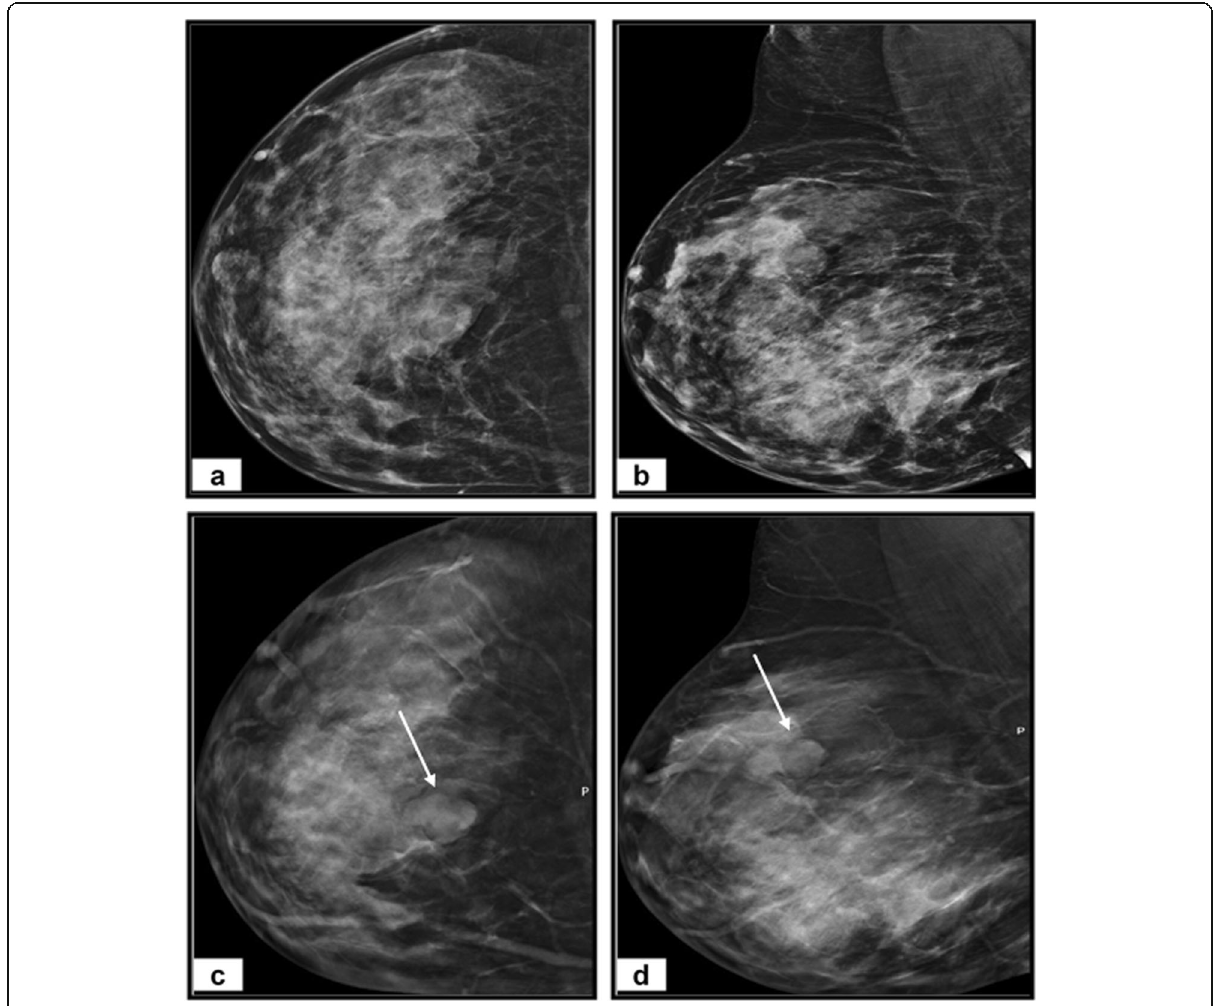
Fig. 5 A 36-year-old woman complains of a right breast lump. a Craniocaudal and ( b ) mediolateral oblique DM images of left breast reveal heterogeneous dense breast (BI-RADS C). The DM images are inconclusive and need further assessment. c Craniocaudal and ( d ) mediolateral oblique DBT images show upper inner quadrant medium density oval-shaped lesion with macrolobulated margins and measures 22 × 20 mm (arrows). The lesion was categorized as BI-RADS 0 by DM and BI-RADS III by DBT. Histopathology after US-guided biopsy revealed